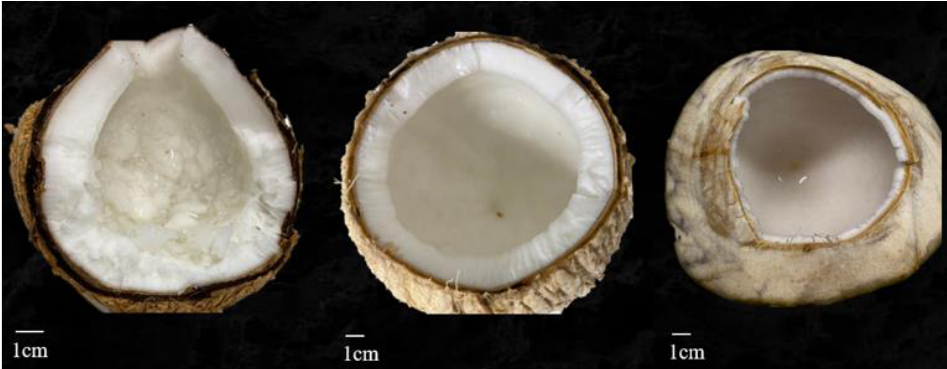
Figure 1. Halved fruits of 10-month-old Makapuno ( left ), 10-month-old mature coconut ( center ), and 6-month-old young coconut ( right